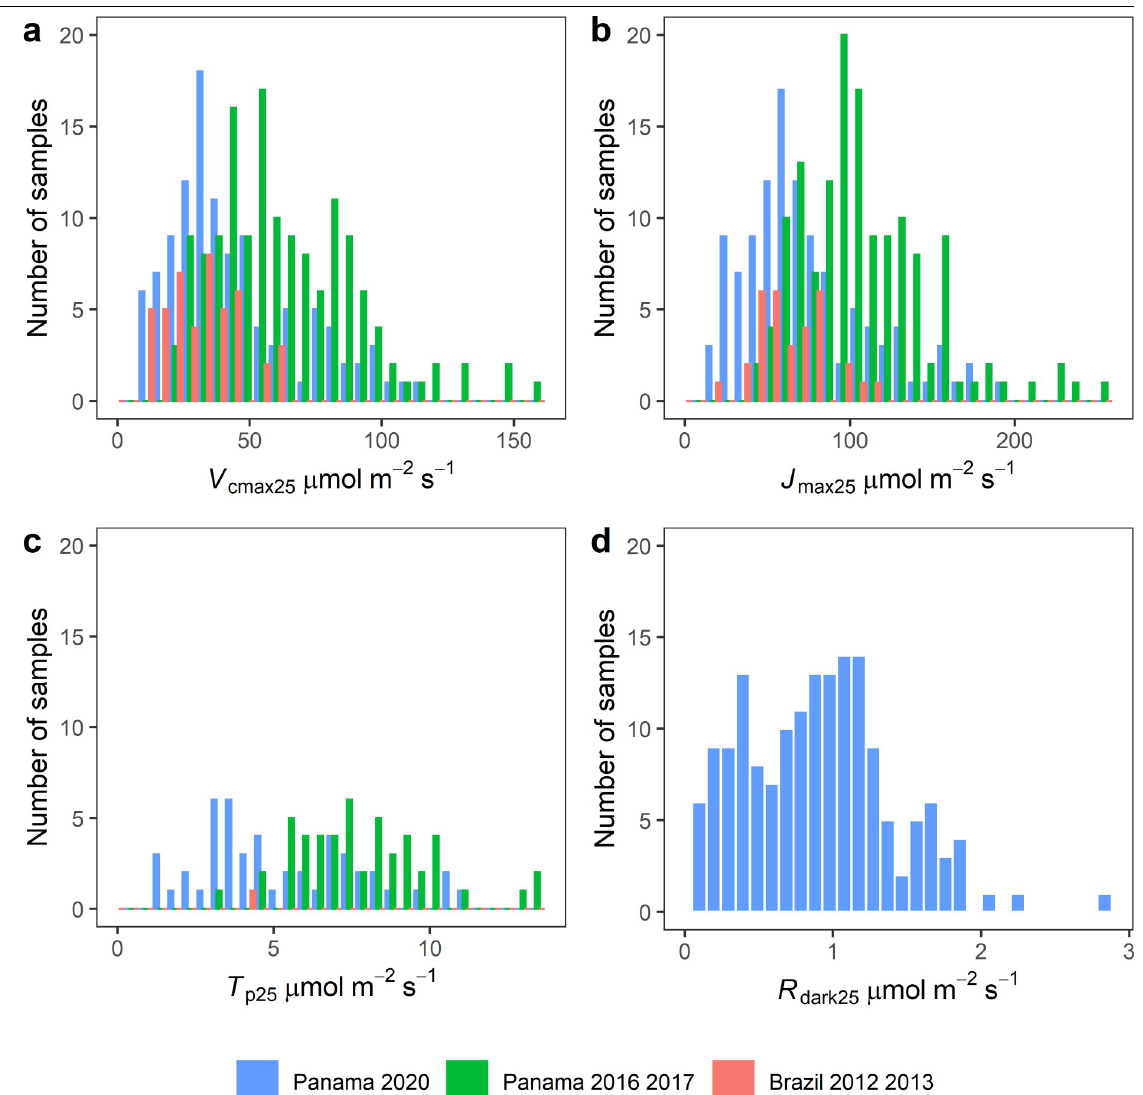
Fig 2. Histogram of the parameters V cmax25 , J max25 , R dark25 and T p25 . V cmax25 (a), J max25 (b), R dark25 (c) and T p25 (d) correspond to the fitted values from the A-C i curves and to measurements of dark acclimated leaves sampled in a large variety of tropical species, leaf ages and canopy